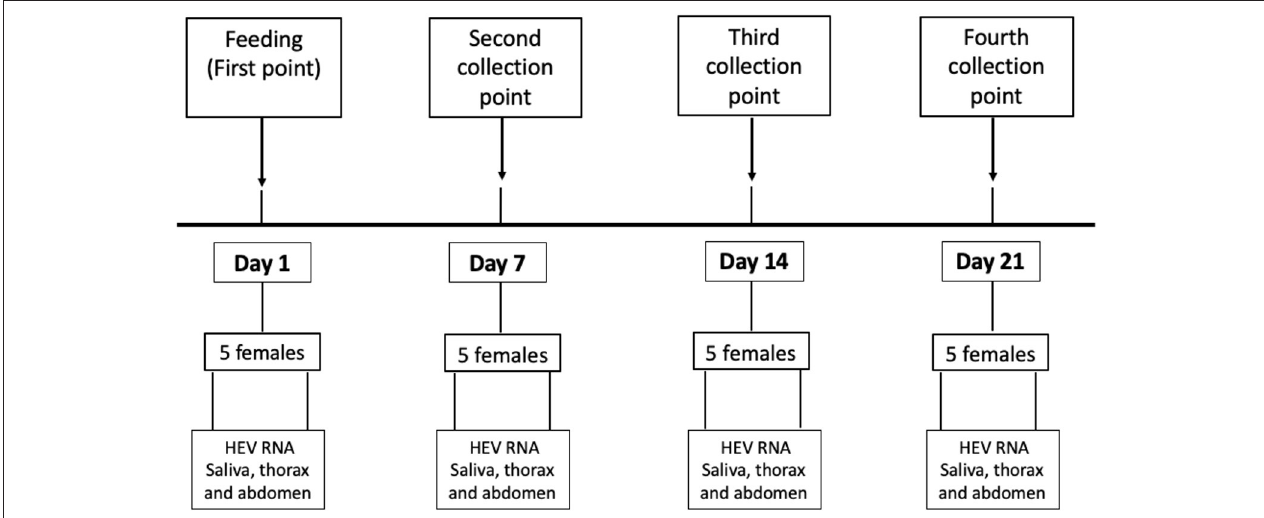
FIGURE 4 | Methodological and chronological design of the